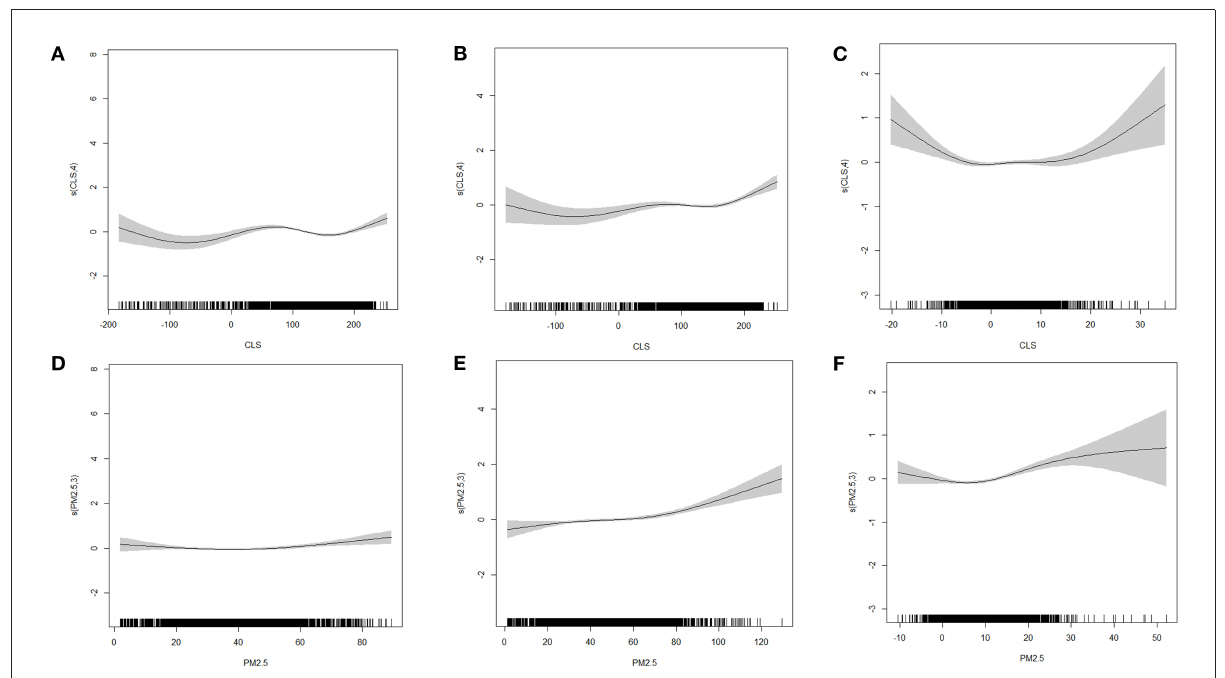
FIGURE3 The GAM model fitting diagram of CLS, PM 2.5 without interaction (A, D) 2000 (B, E) 2010 (C, F)